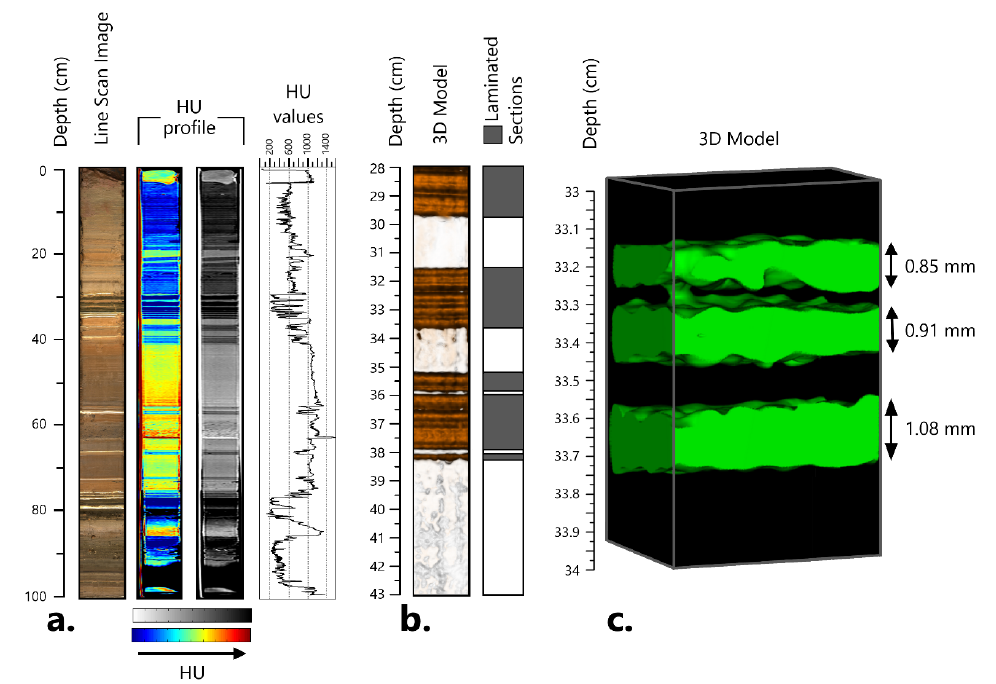
Figure 3. ( a ) Representative 1 m core section with line scan image, HU color and grayscale model, and HU absolute values. ( b ) Varved section with HU values boundaries as they appear during 3D rendering. Laminated sections are presented with brown color and bulk non-laminated sediment with white color. ( c ) Magnified image of 3 distinct laminations. Calcium-rich laminations are presented with green color.